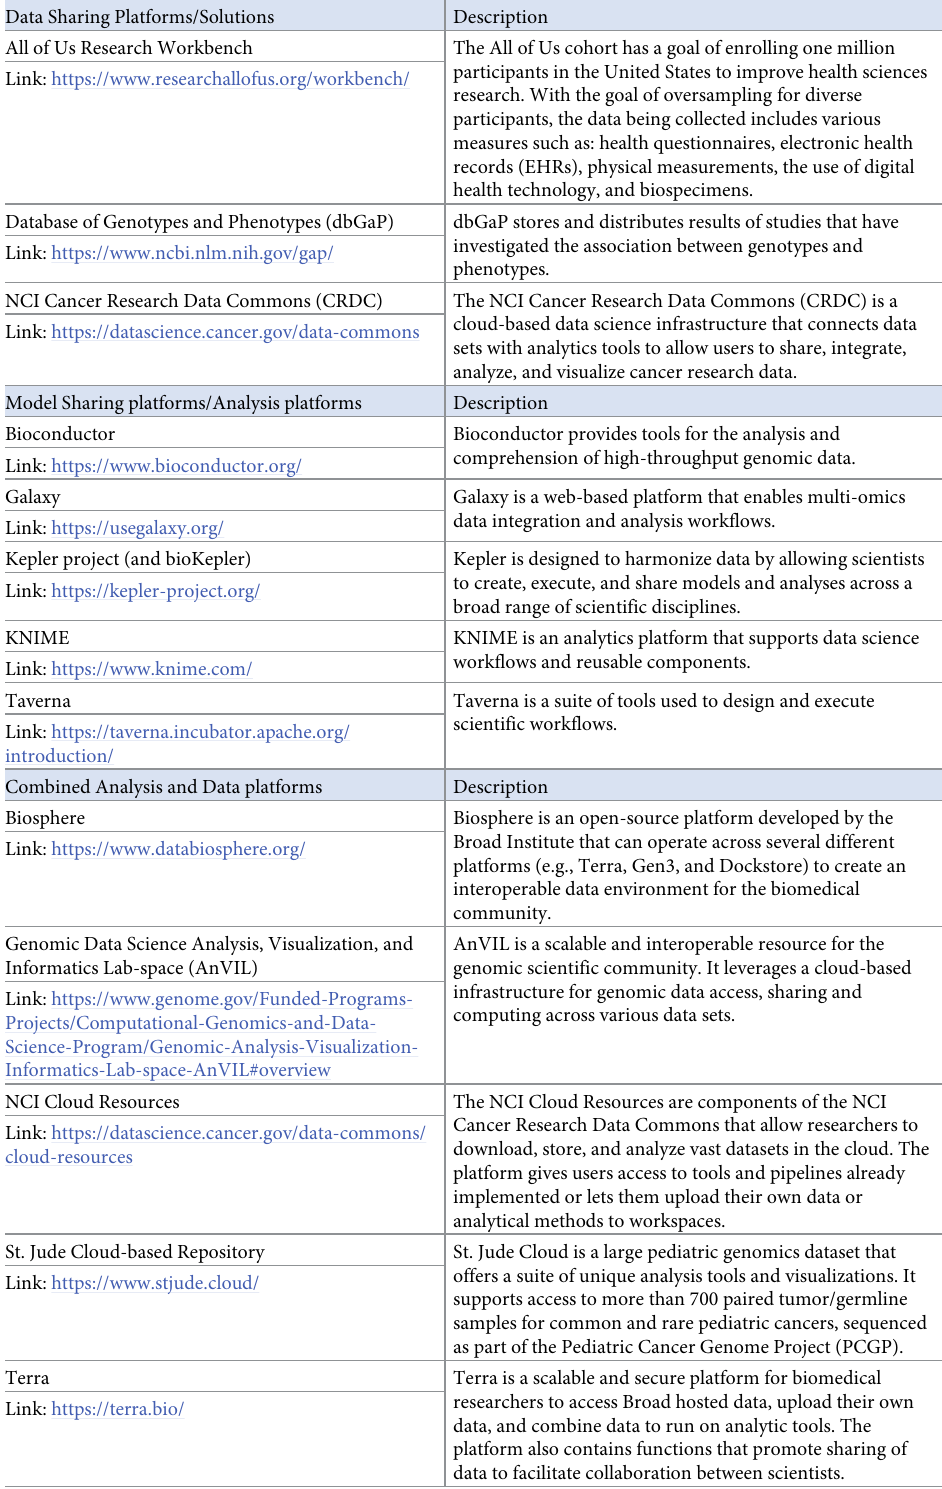
Table 2. Example platforms supporting sharing of data and analytical models or